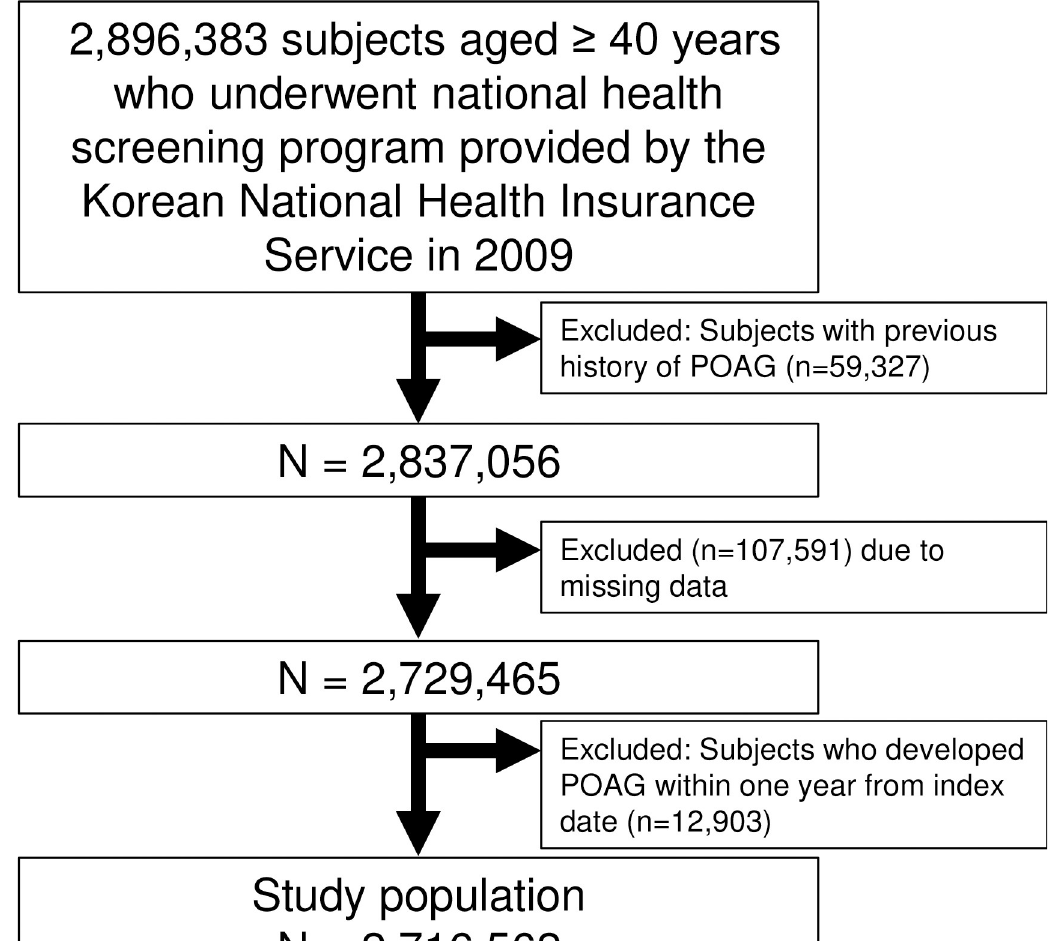
Fig 1. Selection of study